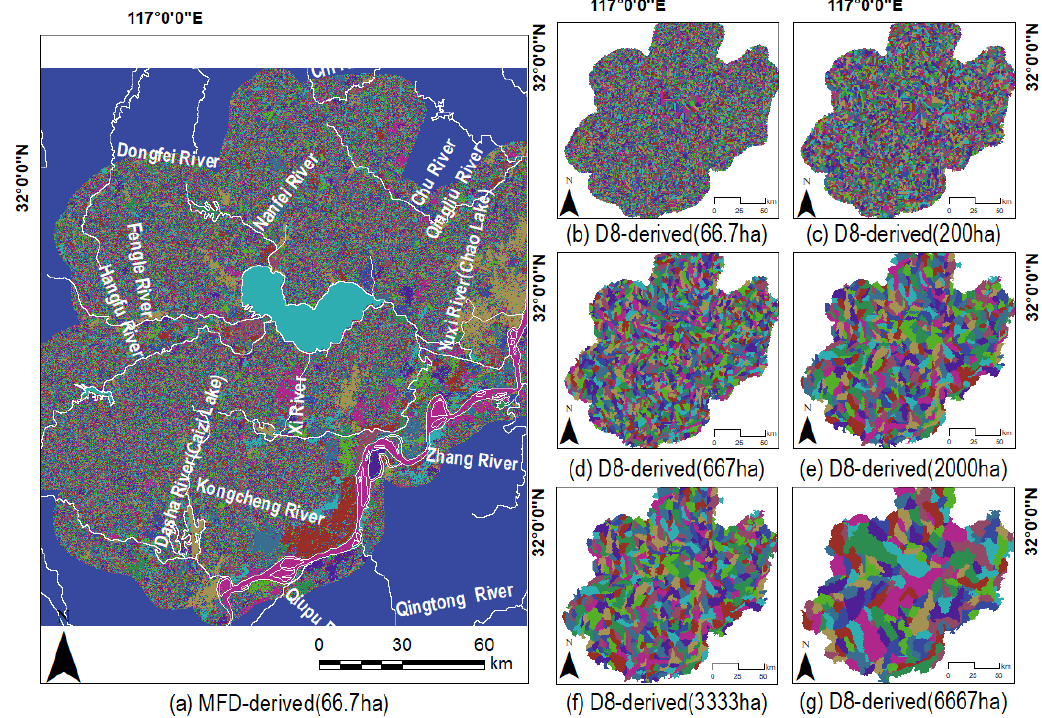
Figure 4. The sub-watersheds derived via MFD ( a ) and D8 ( b – g ). The area threshold used in the MFD-derived subwatershed is 66.7 ha, and the area thresholds used in the D8-derived subwater- shed as shown in ( b – g ) are 66.7 ha, 200.0 ha, 667.0 ha, 2000.0 ha, 3333.0 ha and 6667.0 ha, respec-